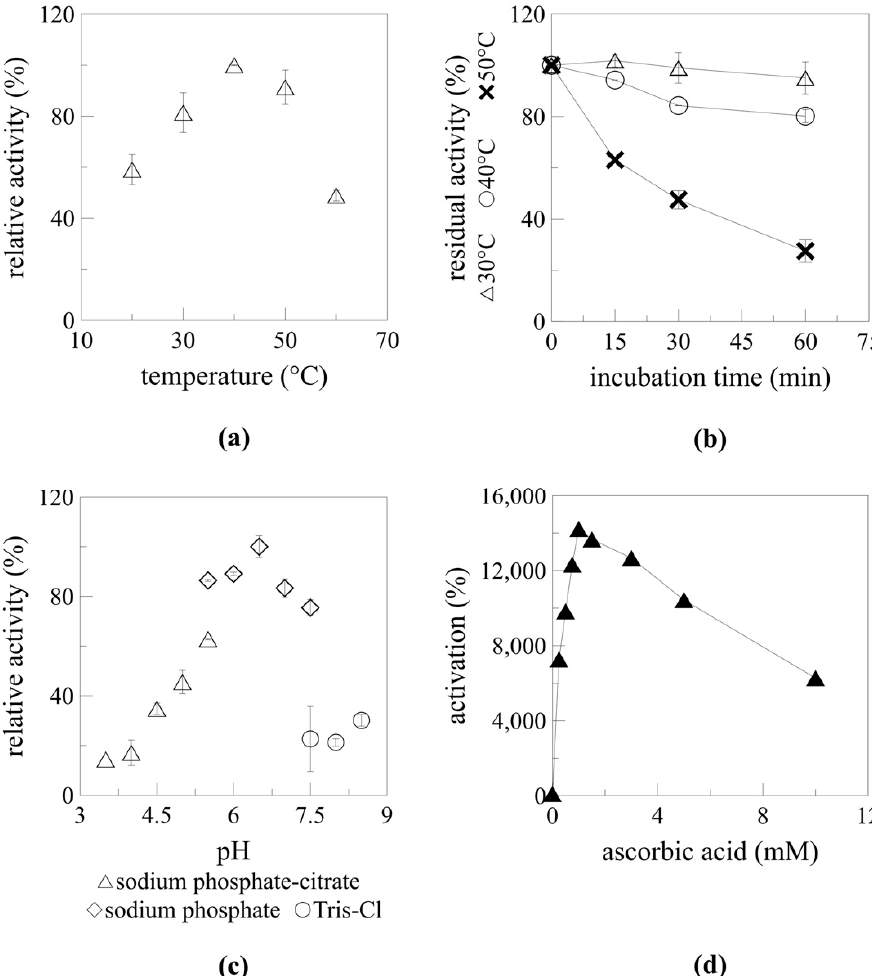
Figure 5. Catalytic properties of recombinant myrosinase. Temperature profile ( a ), operational temperature stability ( b ), pH profile ( c ), and ascorbic acid-dependent activation ( d ) of recombinant At TGG1 myrosinase in the form of culture supernatant.